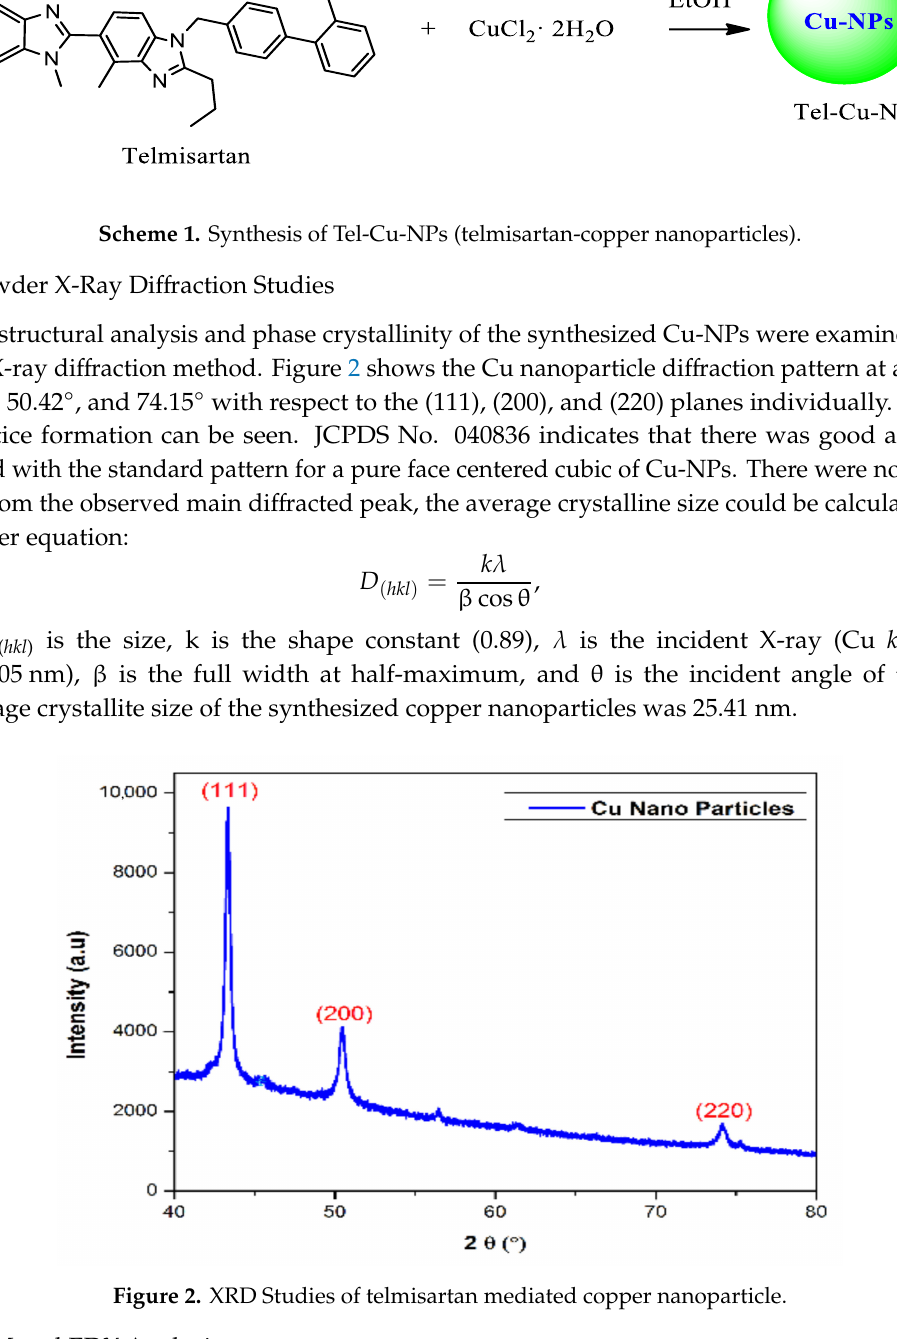
Figure 2. XRD Studies of telmisartan mediated copper nanoparticle. 97